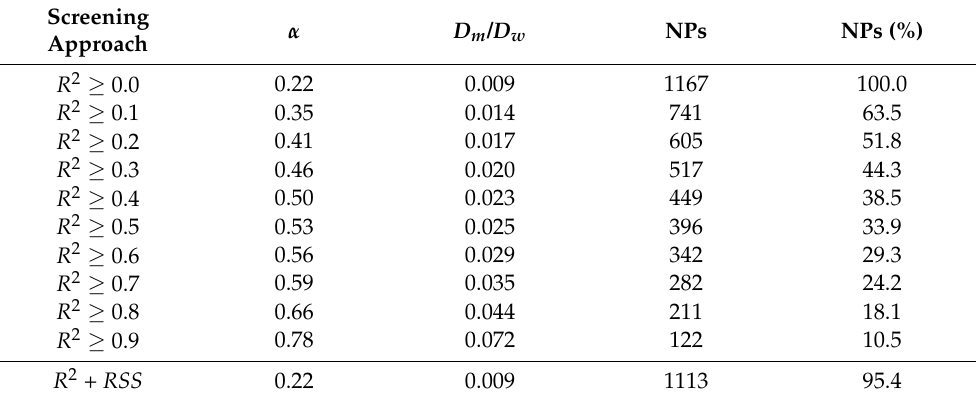
Table 2. Main results of particle tracking experiments performed for non-digested lipid nanocarriers obtained after following different approaches for the screening of trajectories showing poor goodness-of-fit.